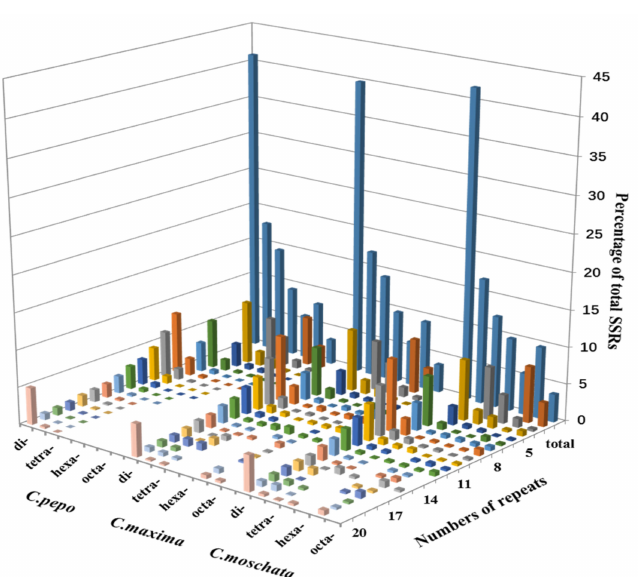
Figure 1. Distribution of SSR motif repeat numbers and relative frequency in Cucurbita genome. The vertical axis shows the abundance of microsatellites that have different motif repeat numbers (from 3 to >20) with different